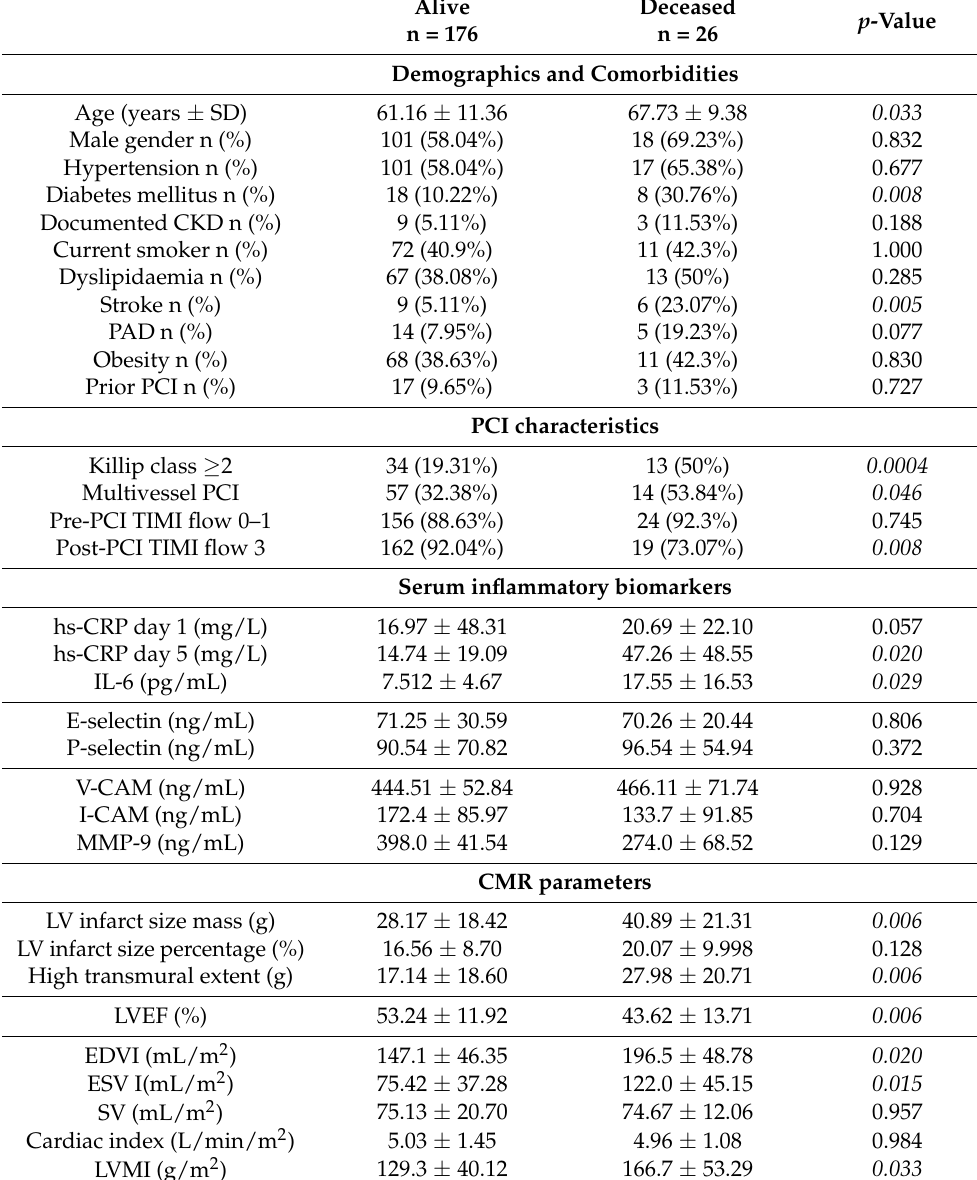
Table 6. Clinical information, PCI, inflammatory biomarkers, and CMR parameters in 2-year sur- vivors and deceased